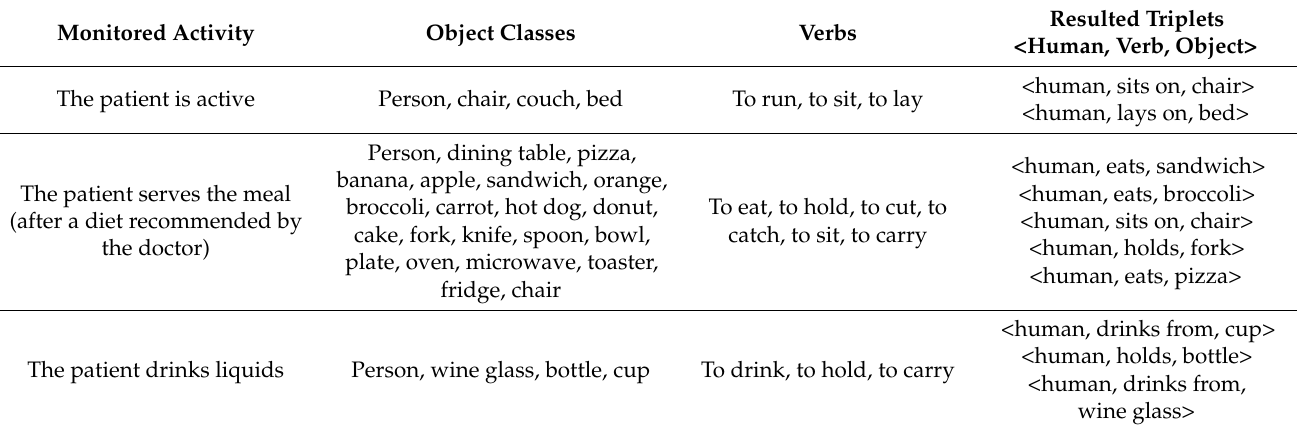
Table 1. Monitoring scenarios for